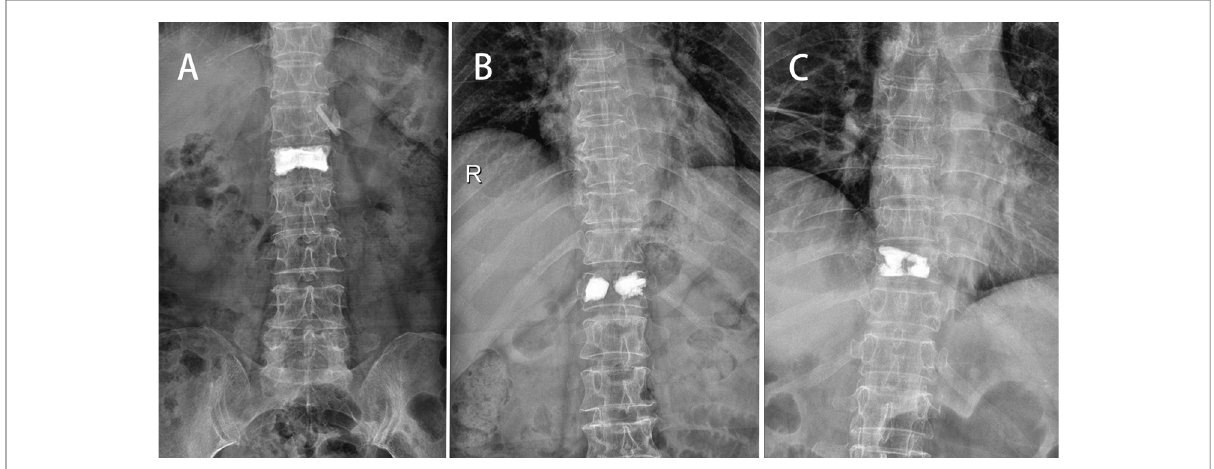
FIGURE 1 In Group A, bilateral diffuse bone cement can be seen on the postoperative anteroposterior radiograph ( A ). In Group B, bilateral dense cement can be seen on the postoperative anteroposterior radiograph ( B ). In Group C, both diffuse and dense bone cement can be seen on the postoperative anteroposterior radiograph ( C